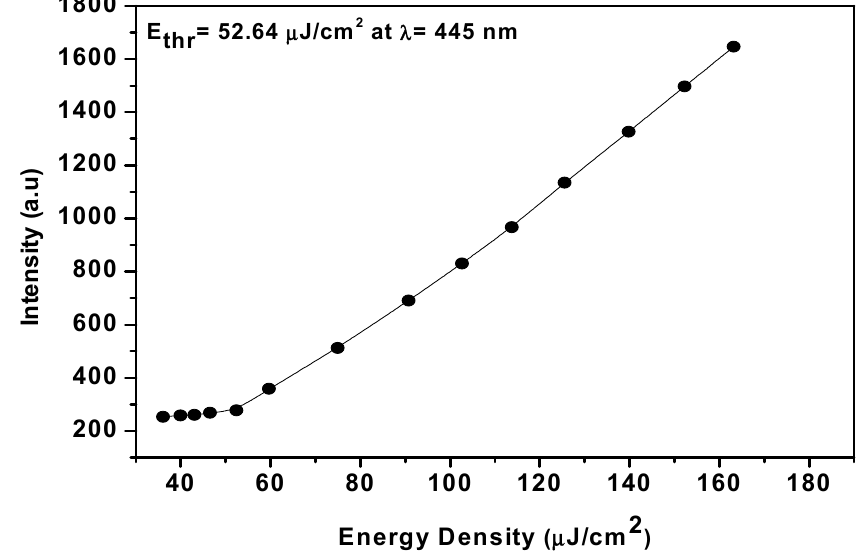
Figure 5. The ASE threshold energy characteristics of P5T at a 445 nm excitation wavelength.